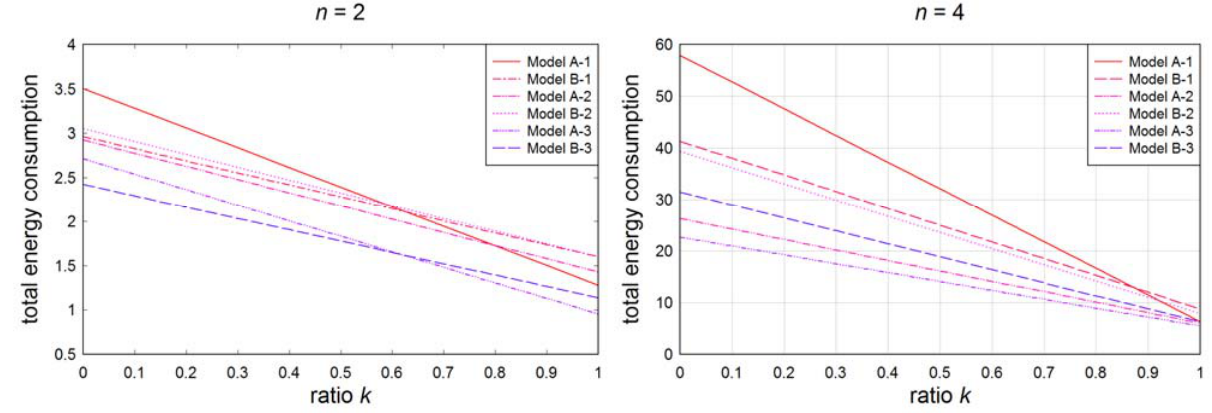
Figure 7. Total energy consumption with various ratios k ( r = 8 m, N =